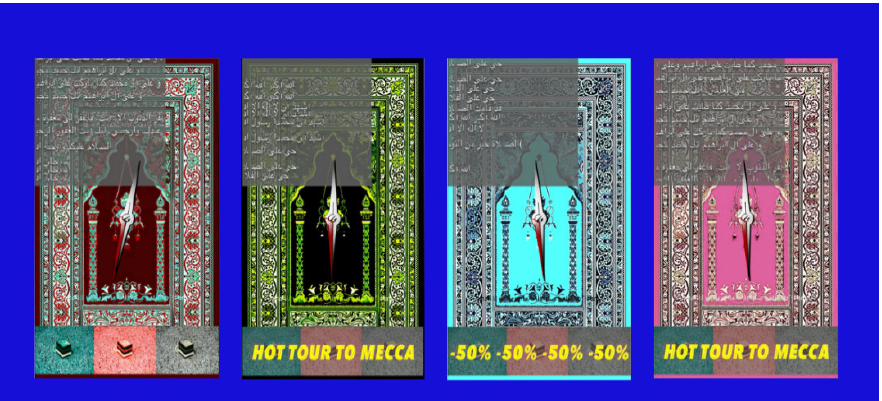
Figure 2. Anvar Musrepov, still from Namaz Maker (2016). Image courtesy of the artist and Aspan Gallery, Almaty.